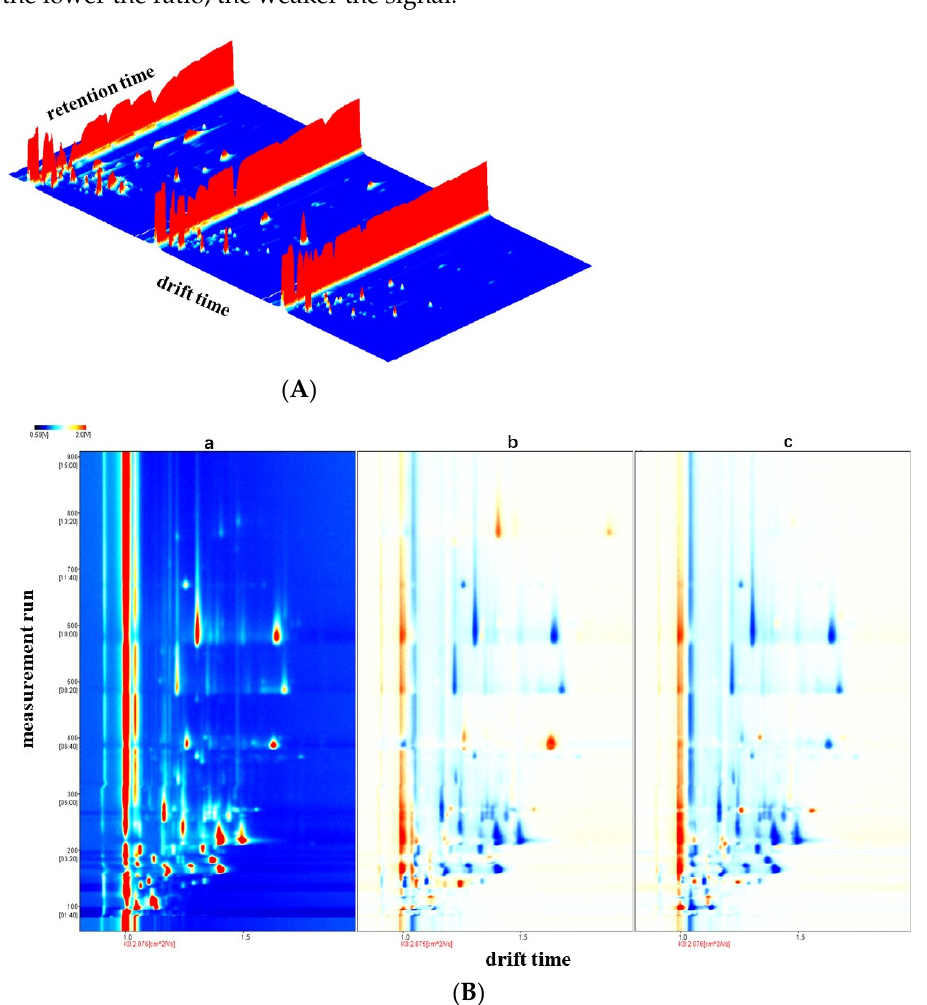
Figure 1. 3D topography for in raw milk from different treatments. ( A ): front view. ( B ): top view. a: The ratio of n ‐ 6 to n ‐ 3 fatty acid in raw milk is 8:1. b: The ratio of n ‐ 6 to n ‐ 3 fatty acid in raw milk is 4:1. c: The ratio of n ‐ 6 to n ‐ 3 fatty acid in raw milk is 3:1.